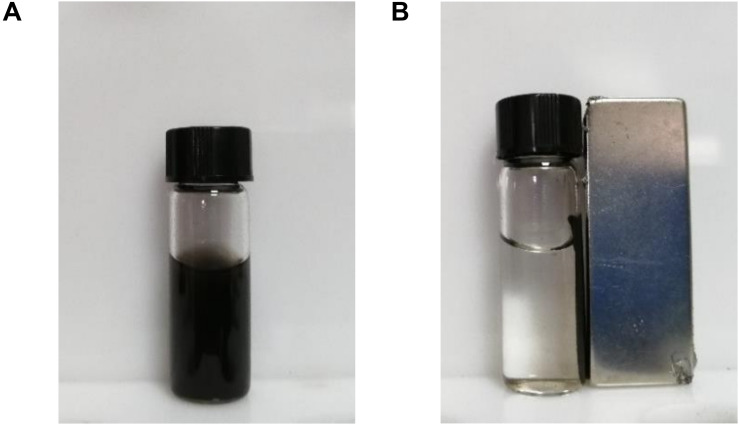
Images of GO (A) and Fe3O4@GO (B).